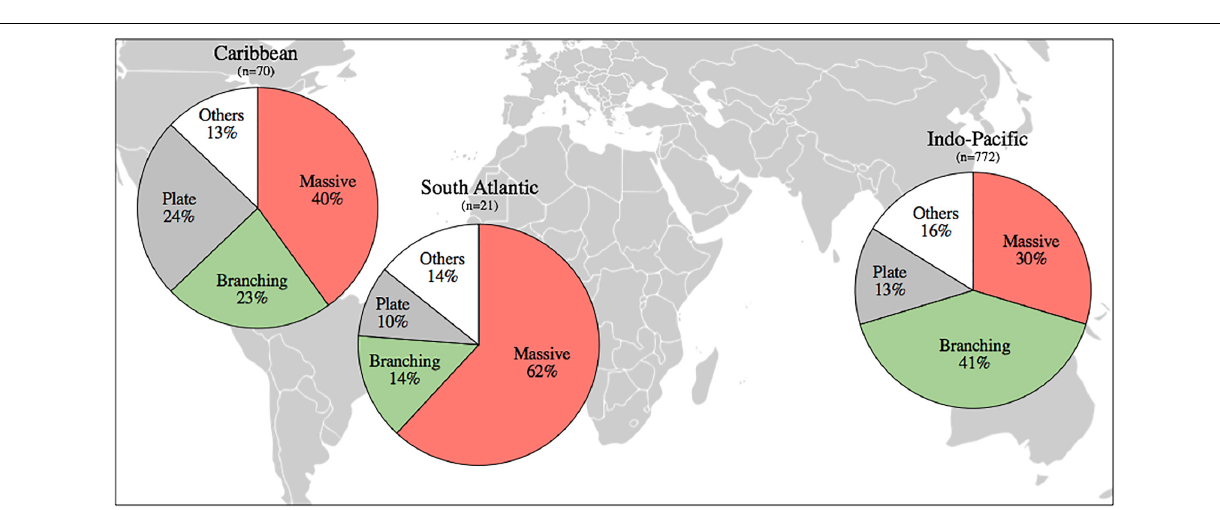
FIGURE 2 | Composition of the main growth forms displayed by corals in Indo-Pacific, Caribbean and South Atlantic reefs. Primary growth morphology data were collected for 850 zooxanthellate scleractinian and hydrocoral species and were divided into four main categories: branching (branching, corymbose, digitate and tabular forms), massive (massive, submassive, hemispherical, dome-shaped and nodule), plate (plate, laminar and foliose) and others (encrusting, phacelloid, meandroid and